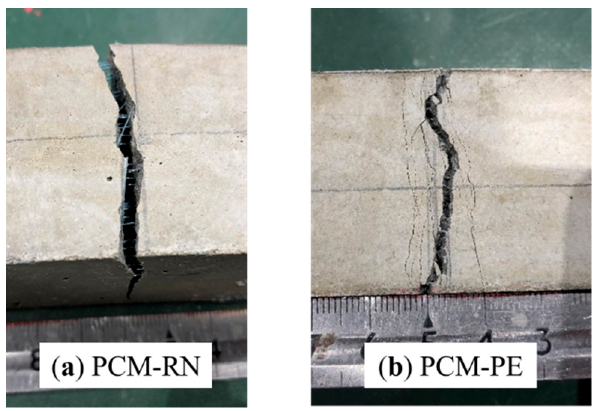
Figure 5. Crack pattern at the bottom surface of the beam: ( a ) PCM–RN; ( b ) PCM–PE.